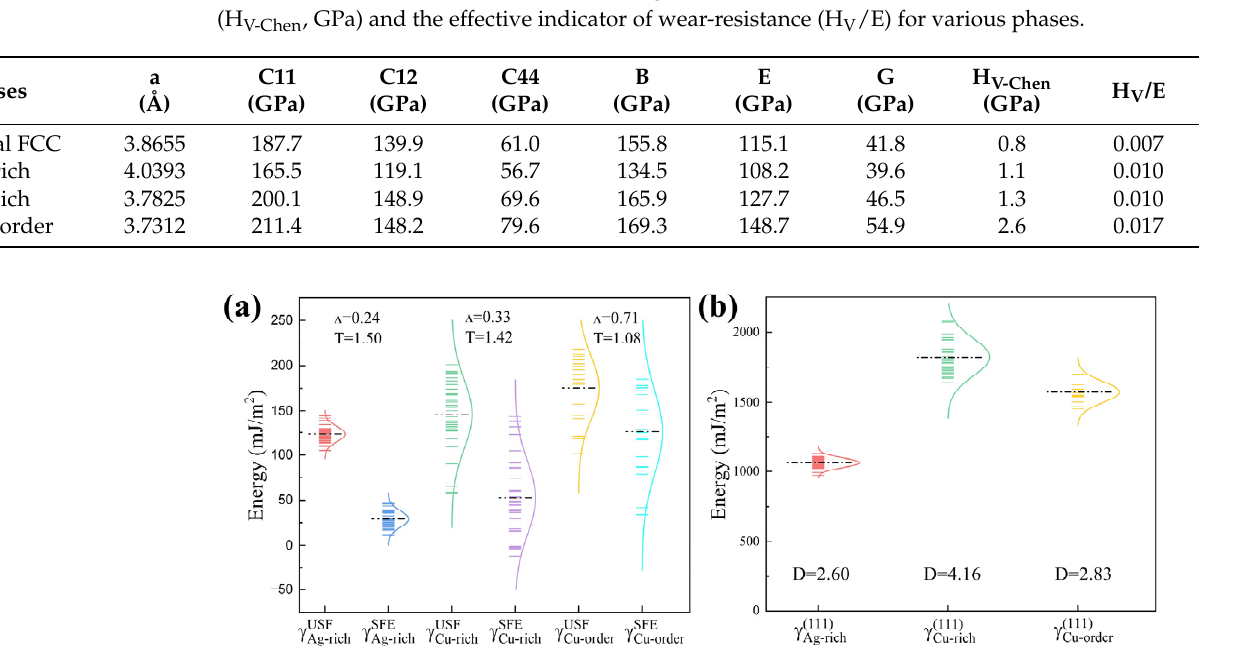
Table 1. First-principles calculation of the lattice parameters (a, Å), elastic constants matrix (C11, C12